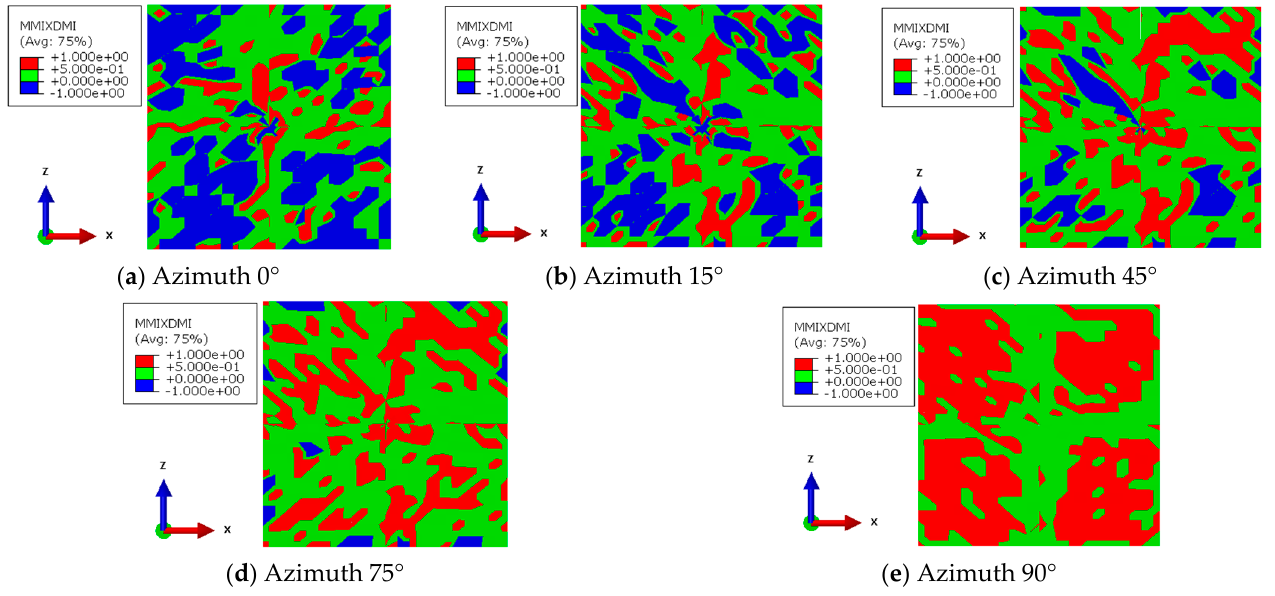
Table 5. Fracture characterization under different radial well azimuths.